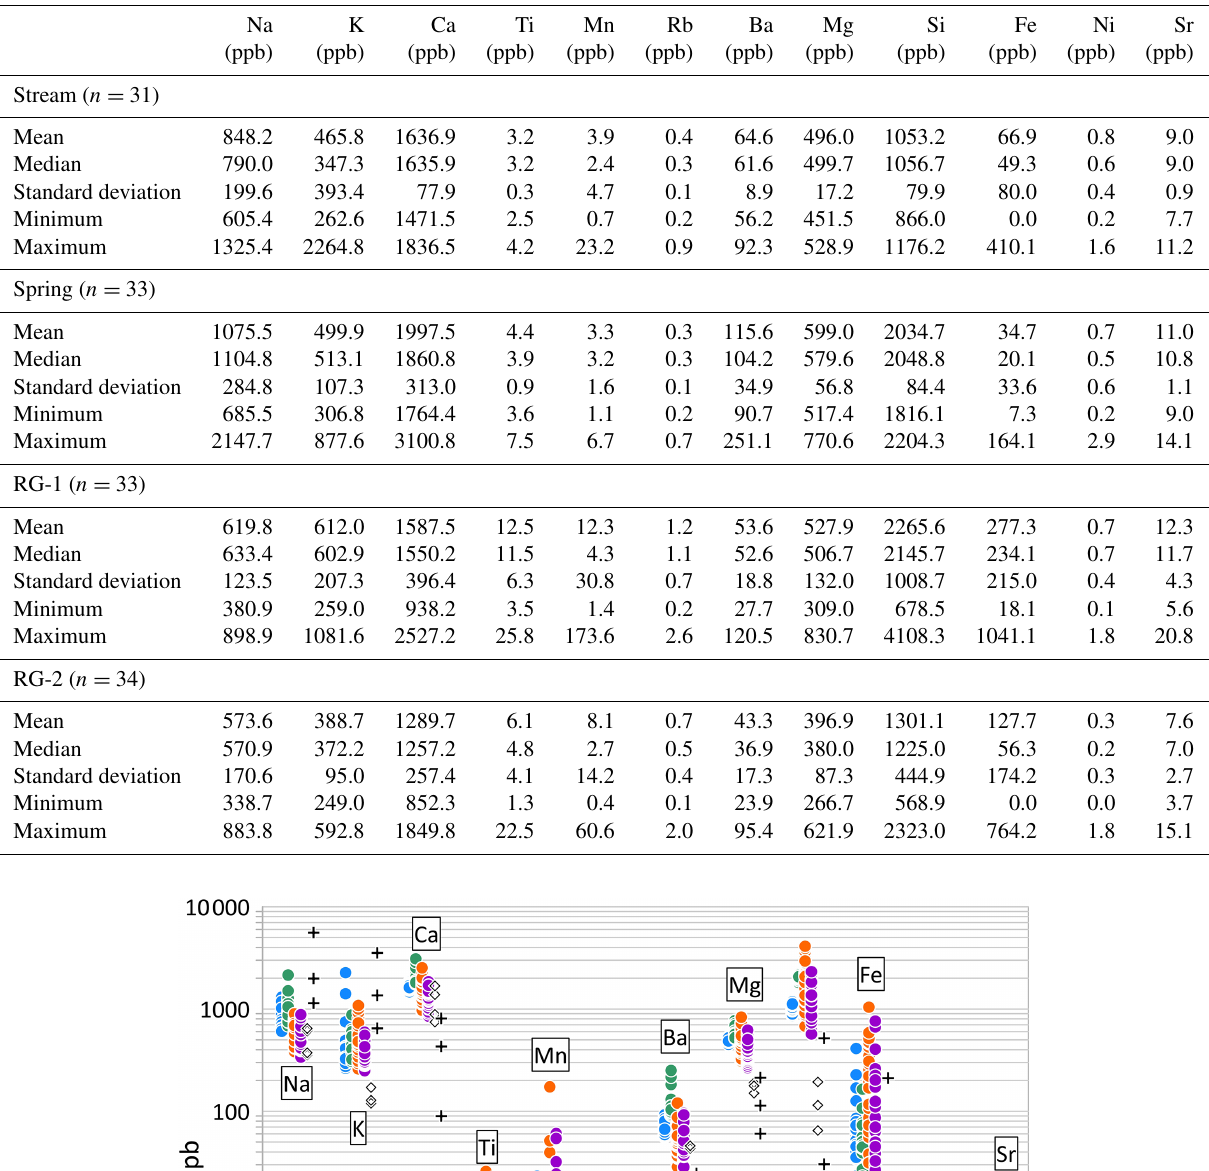
Table 3. Summary hydrochemistry.